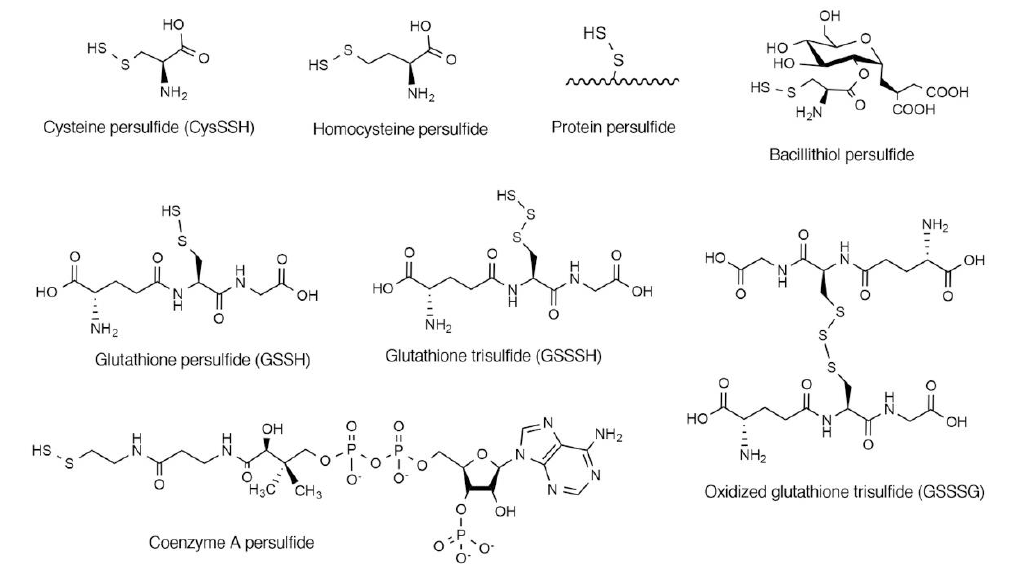
Figure 1. Chemical structures of persulfide species that have been identified in biological systems.